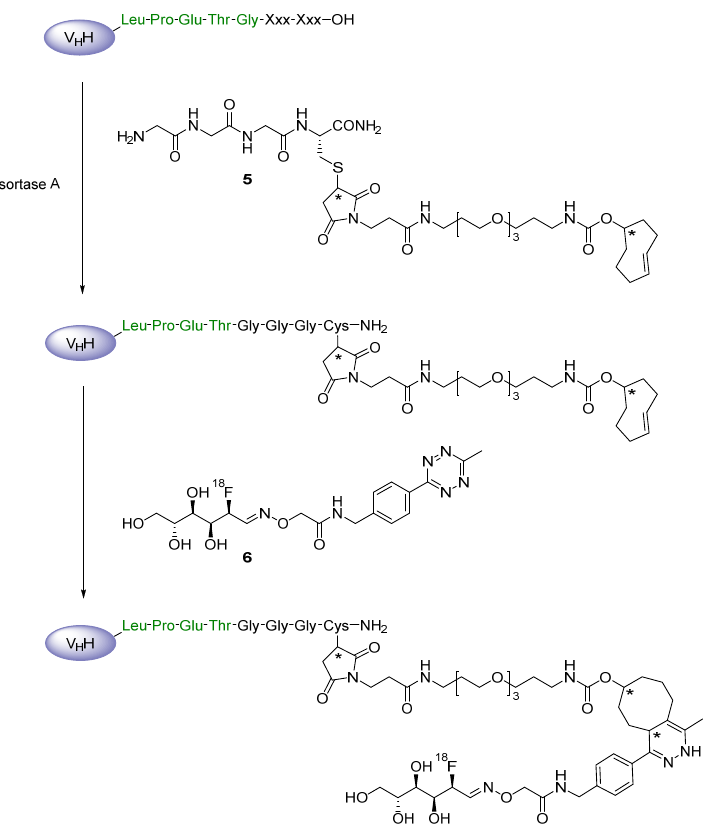
Figure 8. Sortase A-mediated C -terminal introduction of 5 , followed by 18 F-labeling with 6 in an IEDDA reaction.